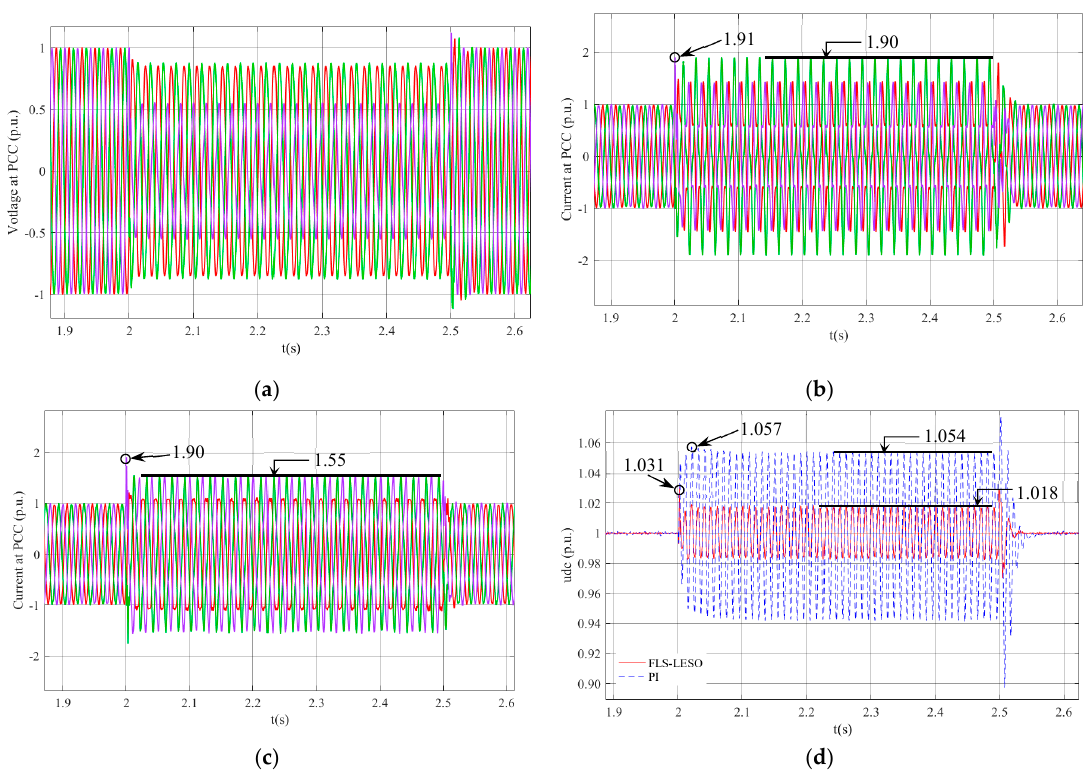
Figure 13. ( a – d ). Dynamic response of a 1.5 MW permanent magnet synchronous generator (PMSG) with the traditional PI controller and fuzzy logic system with linear extended state observer (FLS-LESO) during an unsymmetrical fault; ( a ) Voltage at PCC; ( b ) Current at PCC with the PI controller; ( c ) Current at PCC with the FLS-LESO; ( d ) DC link voltage.